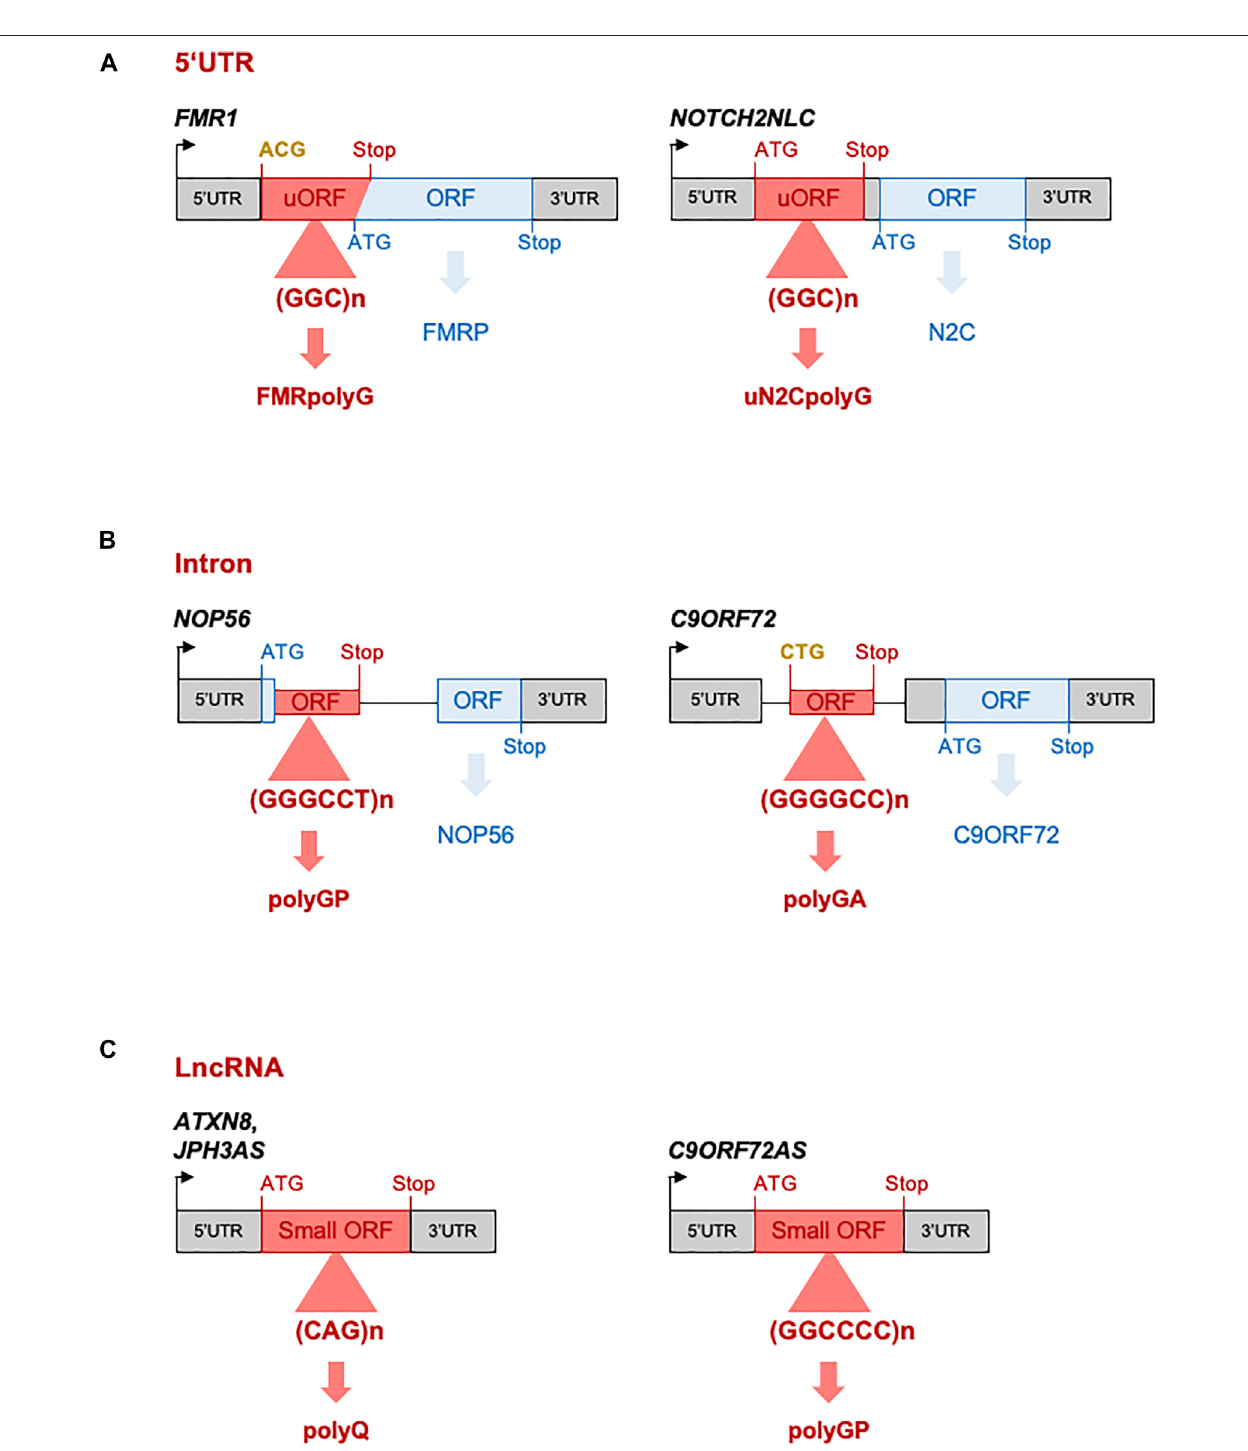
FIGURE 3 | Repeat expansions located in “ non-coding ” regions are nonetheless translated. (A) CGG repeat expansions embedded in FMR1 and NOTCH2NLC 5 ′ UTR are translated into polyglycine-containing proteins in NIID and FXTAS, respectively. (B) G3C2T and G4C2 repeats embedded in the fi rst unspliced intron of the NOP56 and C9ORF72 genes are translated into poly(glycine-proline) and poly(glycine-alanine)-containing proteins in SCA36 and ALS/FTD, respectively. (C) CAG repeats and G2C4 repeats embedded in ATXN8, JPH3AS and C9ORF72AS long “ non-coding ” RNAs are translated into polyglutamine- or poly(glycine-proline)- containingproteinsinSCA8,HDL2,andALS/FTD,respectively.InitiationcodonsandstopcodonsoftheORFscontainingthepathogenicexpansionareindicatedinred, while they are indicated in blue for the main ORFs. Near-cognate initiations codons are indicated in bold yellow.